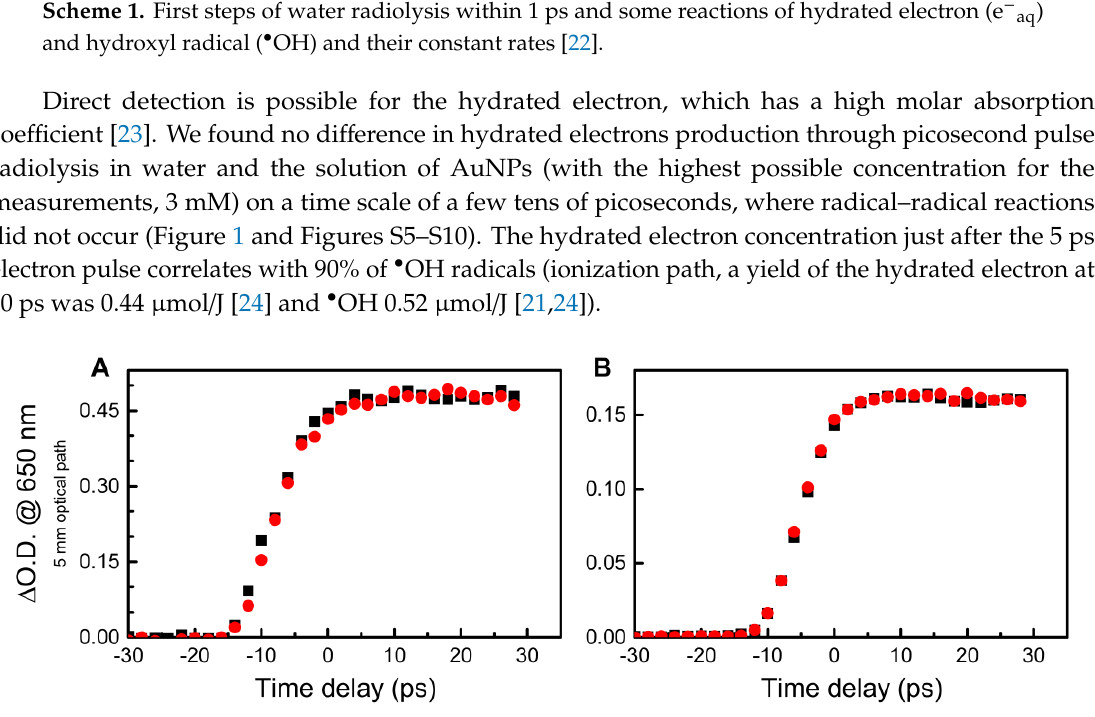
Figure 1. Kinetics of hydrated electrons within a time range of tens of picoseconds after a 5 ps electron pulse in water (black squares) and AuNPs suspensions containing 3 mM of gold atoms (red dots) prepared by borohydride ( A ) and citrate ( B ) reduction methods.